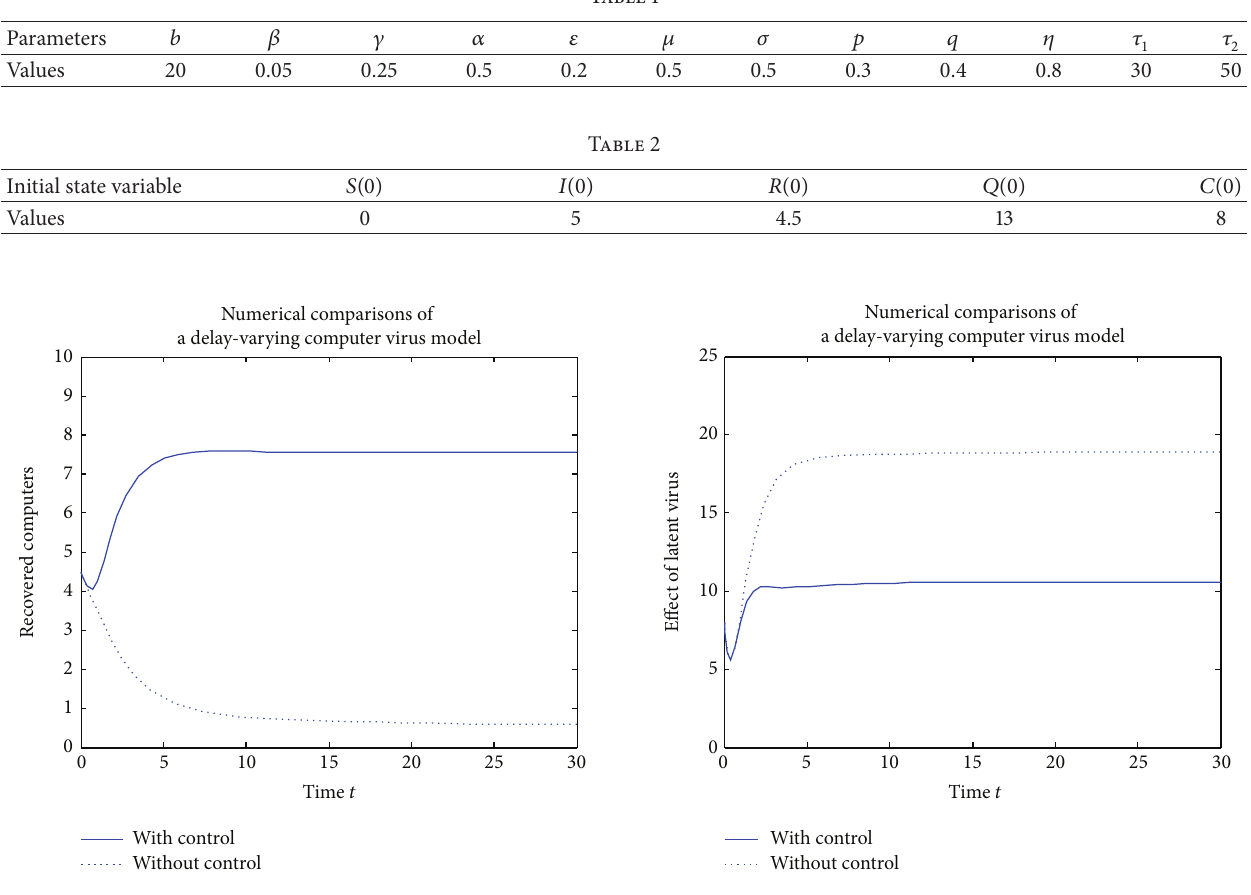
Figure 3: Recovered computers (with and without control) versus time 𝑡 .